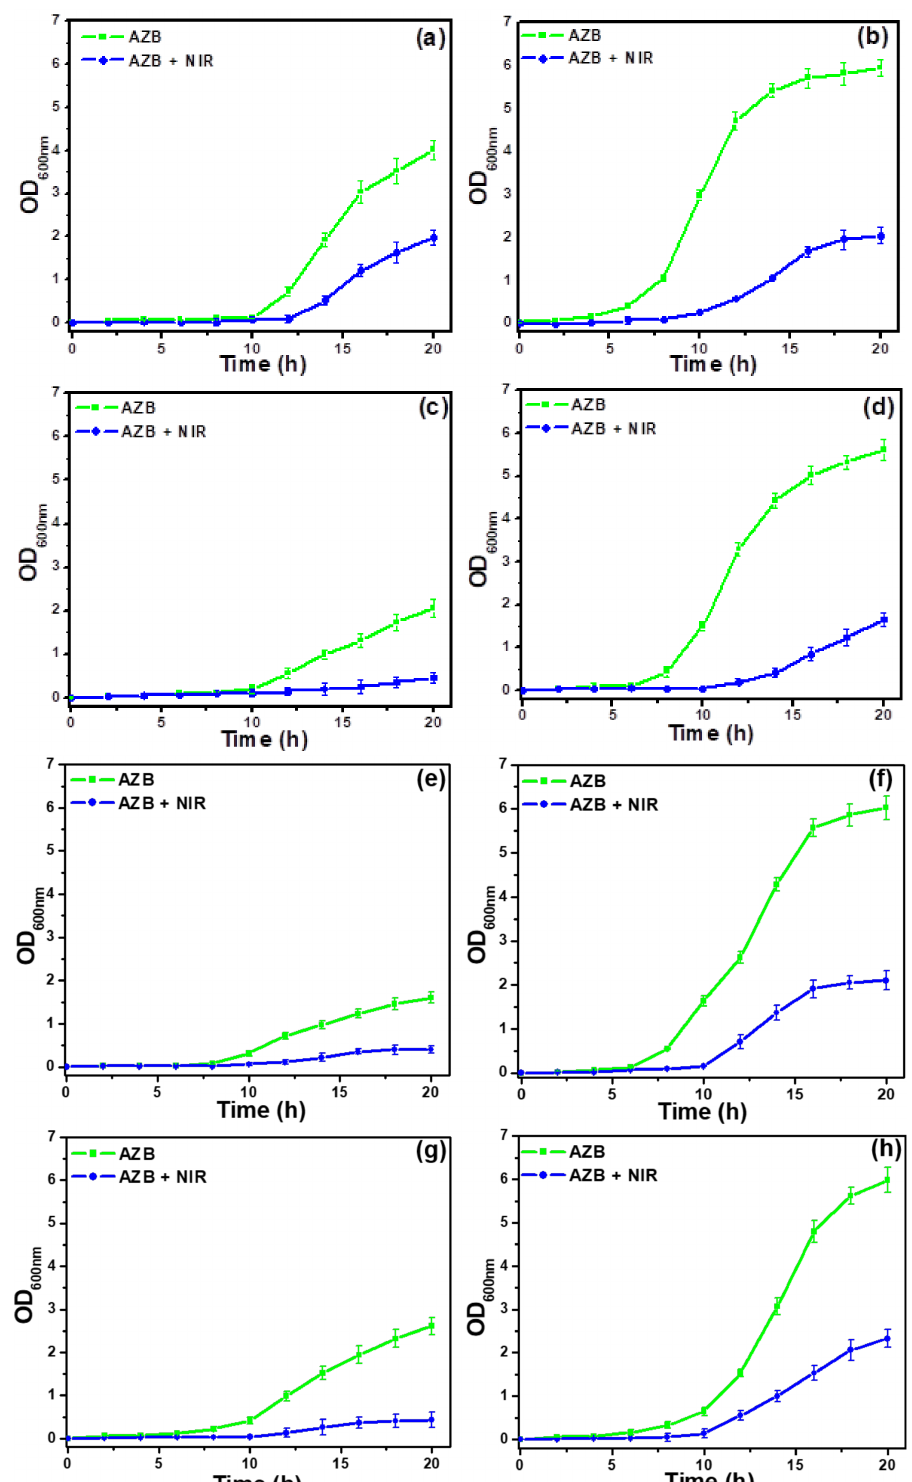
Figure 6. Effect of NIR on antibacterial activity of AZB. Growth curves of ( a ) MRSA1, ( b ) MRSA2, ( c ) MRSA3, ( d ) MRSA4, ( e ) MRSA5, ( f ) MRSA6, ( g ) MRSA7, and ( h ) MRSA8 cells subjected to the AZB and AZB + NIR treatments. The concentration of each AZB nanomaterial was 50 µ g mL − 1 (the data are shown as the mean of